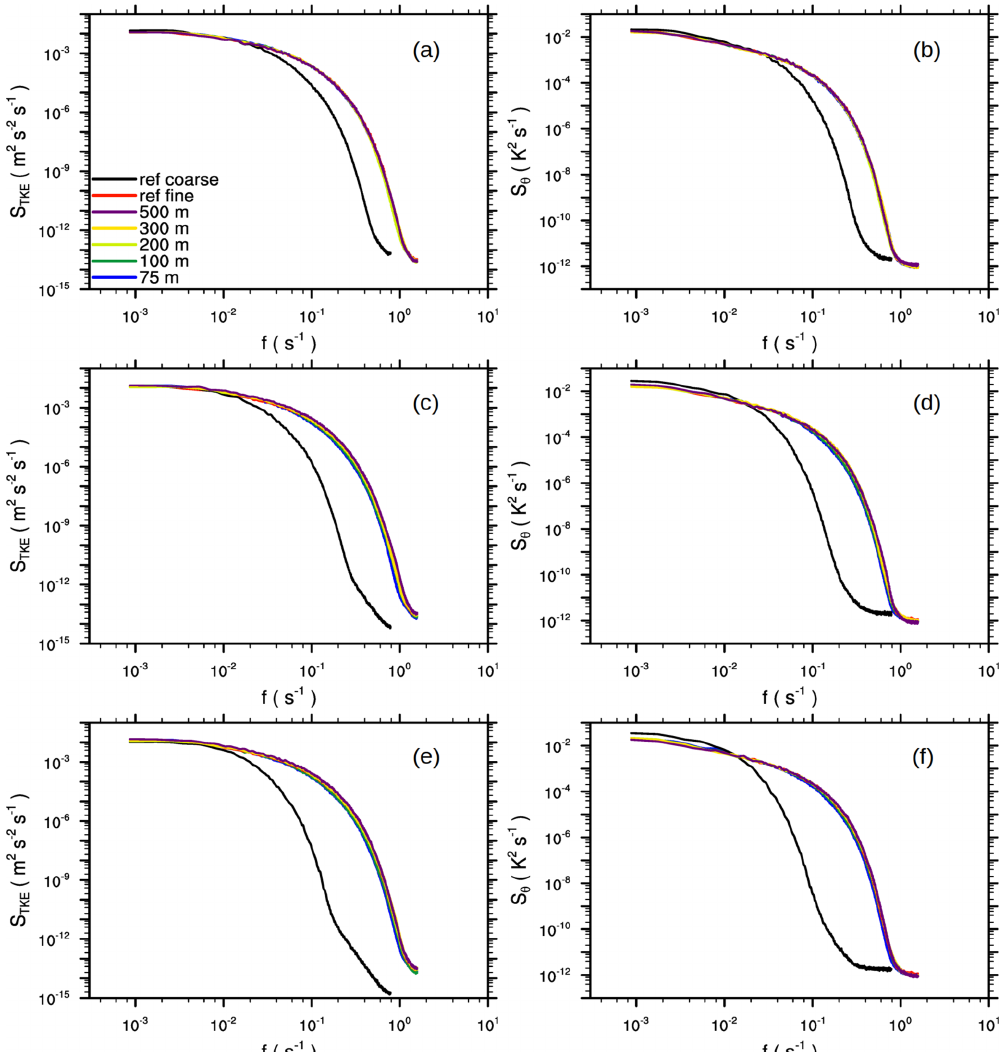
Figure 7. Frequency spectra of the TKE (a, c, e) and θ variance (b, d, f) inside the child domain for the grid-spacing ratio of 2 (a, b) , 3 (c, d) , and 4 (e, f) . The colored curves represent spectra taken at different distances away from the lateral child boundaries. Furthermore, spectra for fine-grid (and corresponding coarse-grid) reference simulations are displayed. TKE and θ were sampled at z = 120m.